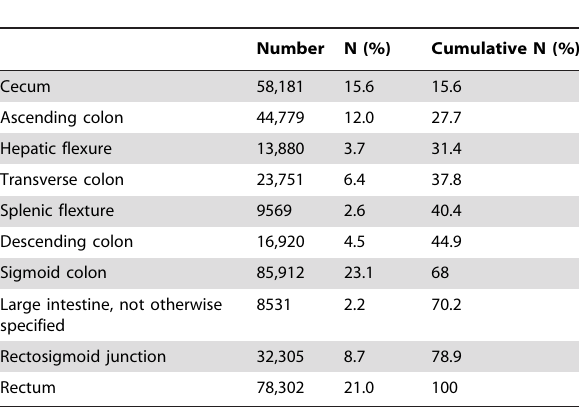
Table 2. Distribution of colorectal adenocarcinoma among the different sites.